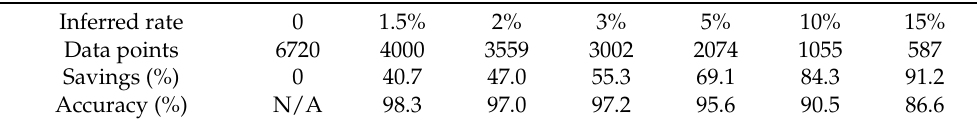
Table 2. Large Sample of Inference Rate for 24 h HR data (seconds) to compare variance rates (VR) related to Savings and Accuracy Rates.